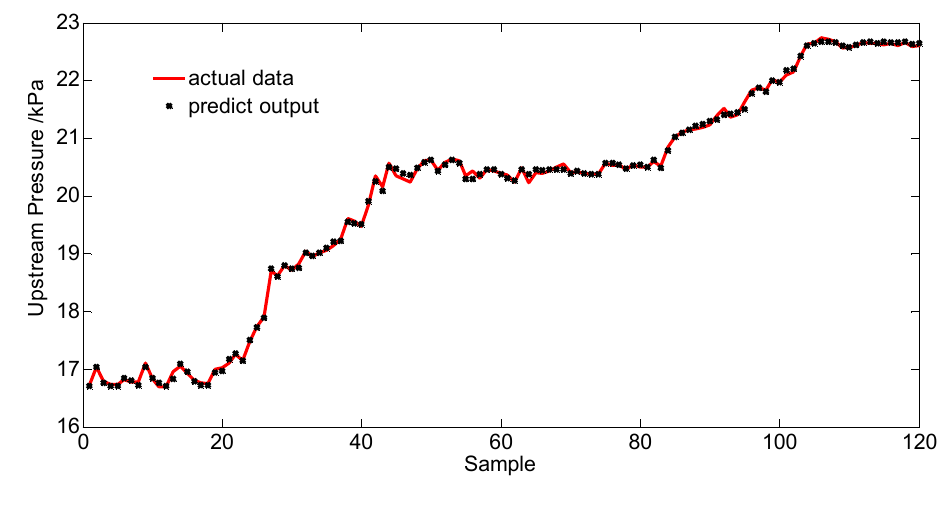
Figure 4. Comparison between the actual values and predict